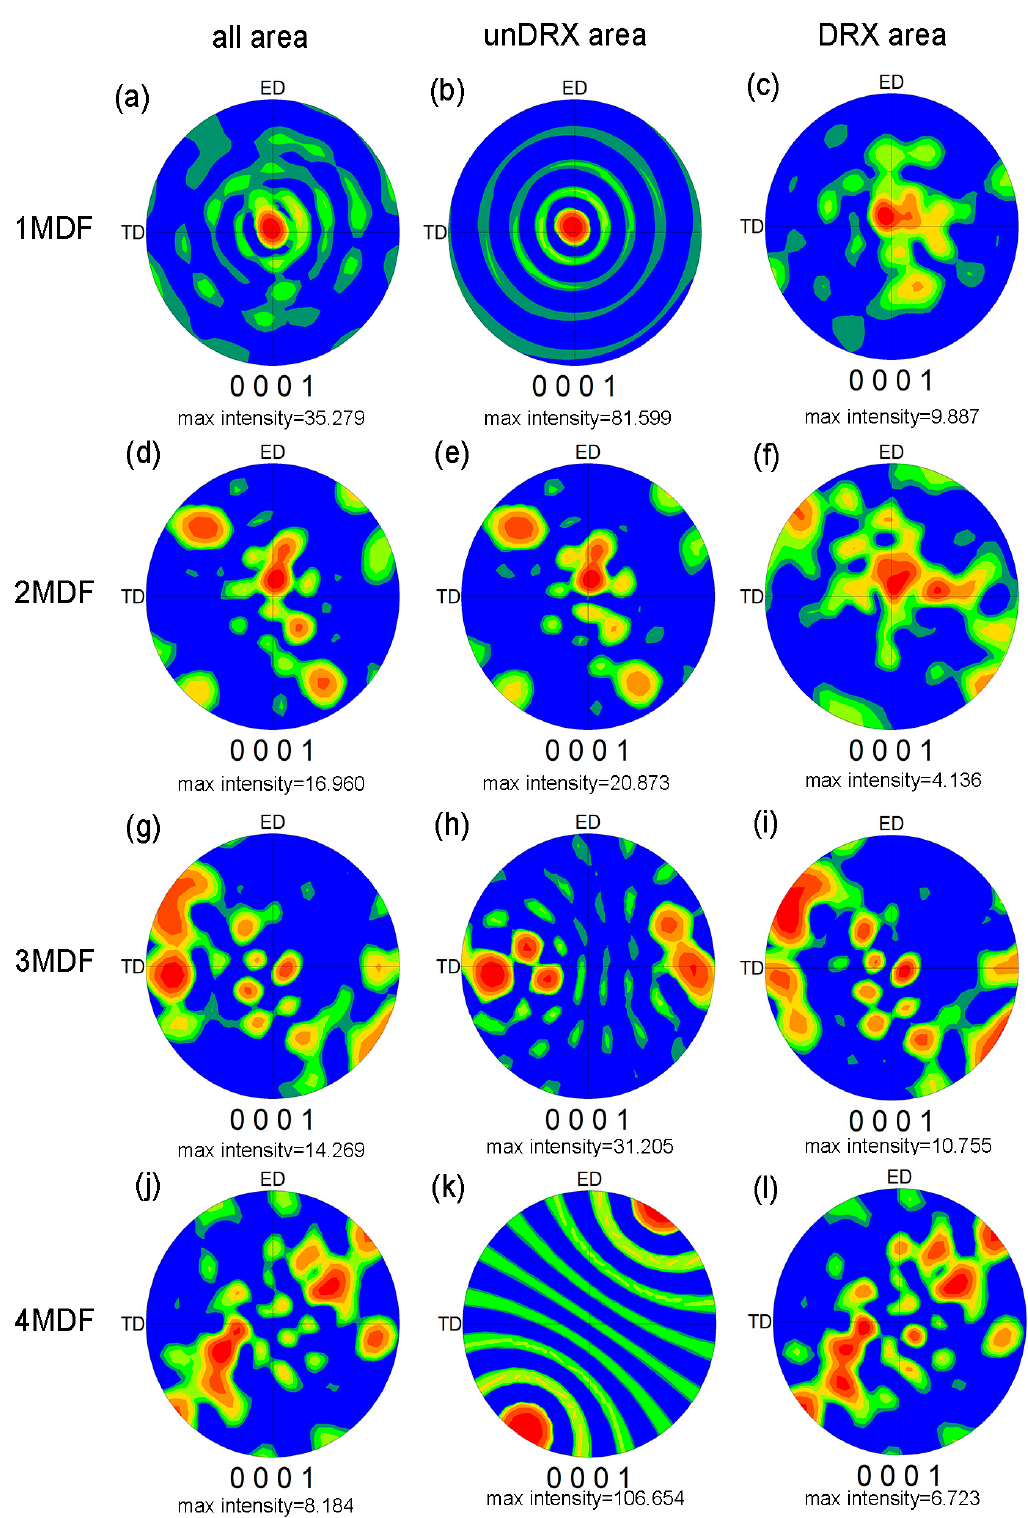
Figure 11. The {0001} pole figure (PF) of the specimens after MDF to different passes, ( a , d , g , j ) the {0001} pole figure (PF) of all area after different passes, ( b , e , h , k ) the {0001} pole figure (PF) of unDRX area after different passes, ( c , f , i , l ) the {0001} pole figure (PF) of DRX area after different passes.